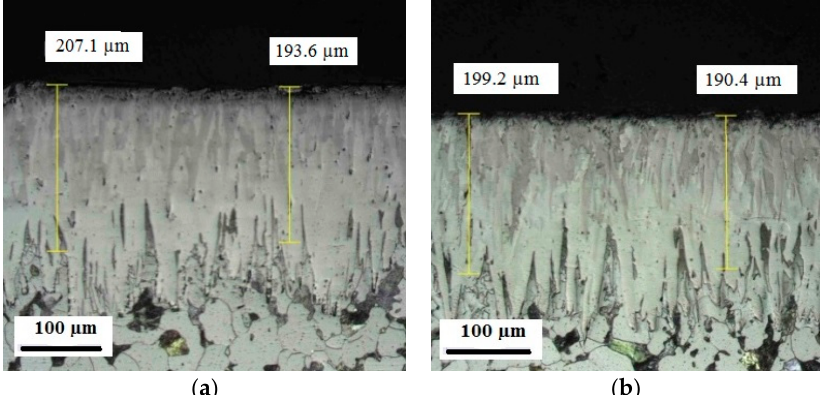
Figure A6. Microscopic images of the cross-section of CS-B-Z ( a ) before and ( b ) after the low-temperature corrosive attack after 168 h.